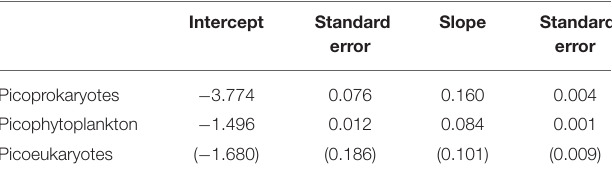
Intercept Standard